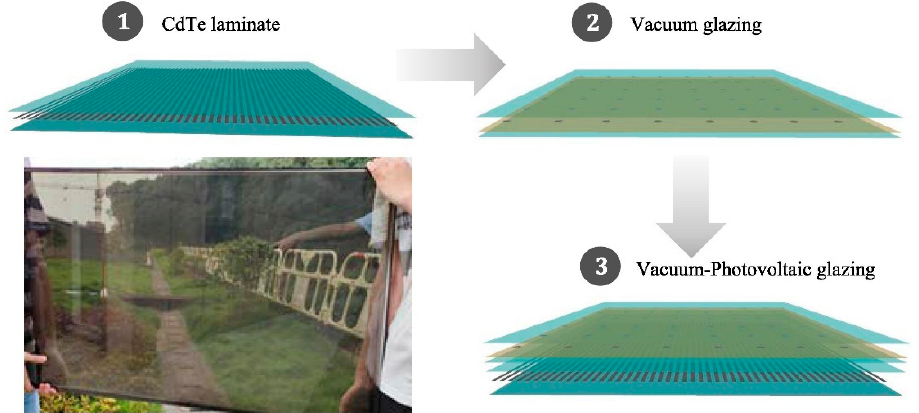
Figure 23. Example of PV-GU system components [66].